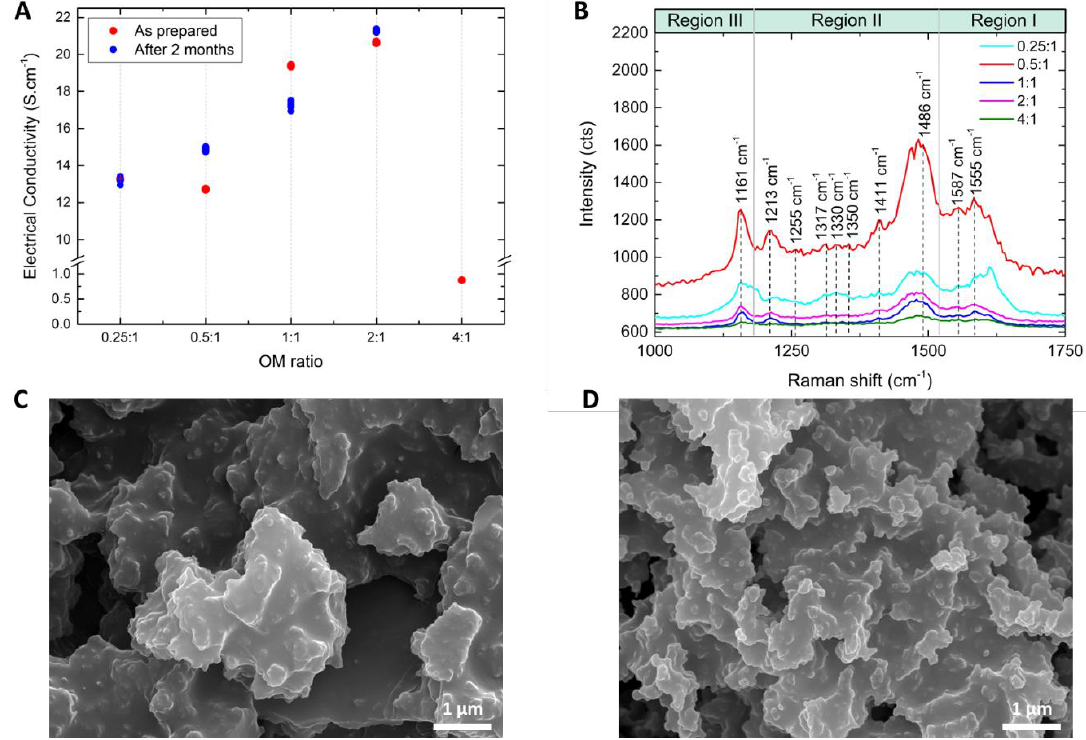
Figure 2. ( A ) Electrical conductivity of PANI pellets measured as prepared (red circles) and after 2 months (blue circles) in order to OM ratio; ( B ) Raman spectra of different PANI OM ratios synthesized; ( C ) SEM micrographs of synthesized powders of PANI 2:1 OM ration and ( D ) PANI t-Boc protected powders.